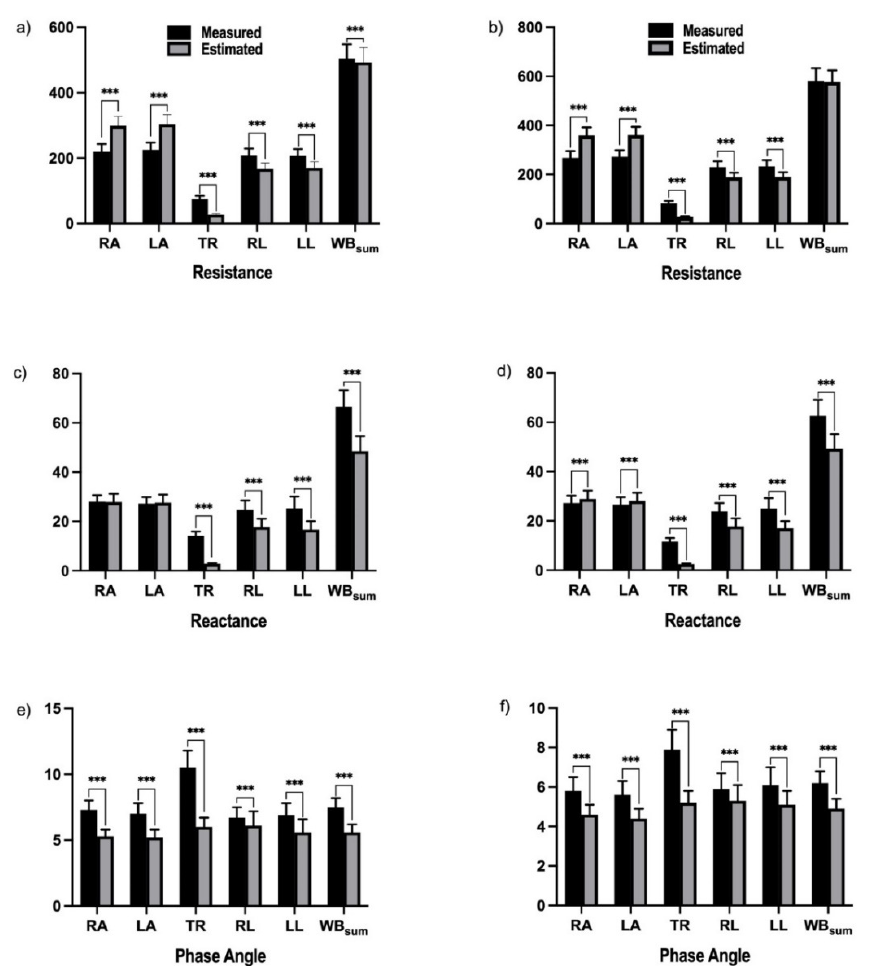
Figure 2. Comparison of the estimated impedance parameters to the measured impedance parameters with respect to resistance ( R ), mean reactance ( Xc ), and mean phase angle ( PhA ) measured at 50 kHz frequency. ( a , c , e ) correspond to R , Xc , and PhA values in males; ( b , d , f ) correspond to R , Xc , and PhA values in females. WB sum : Whole body as the sum of the segments for right arm, trunk, and right leg. *** = difference between the estimated and measured values at p < 0.001.